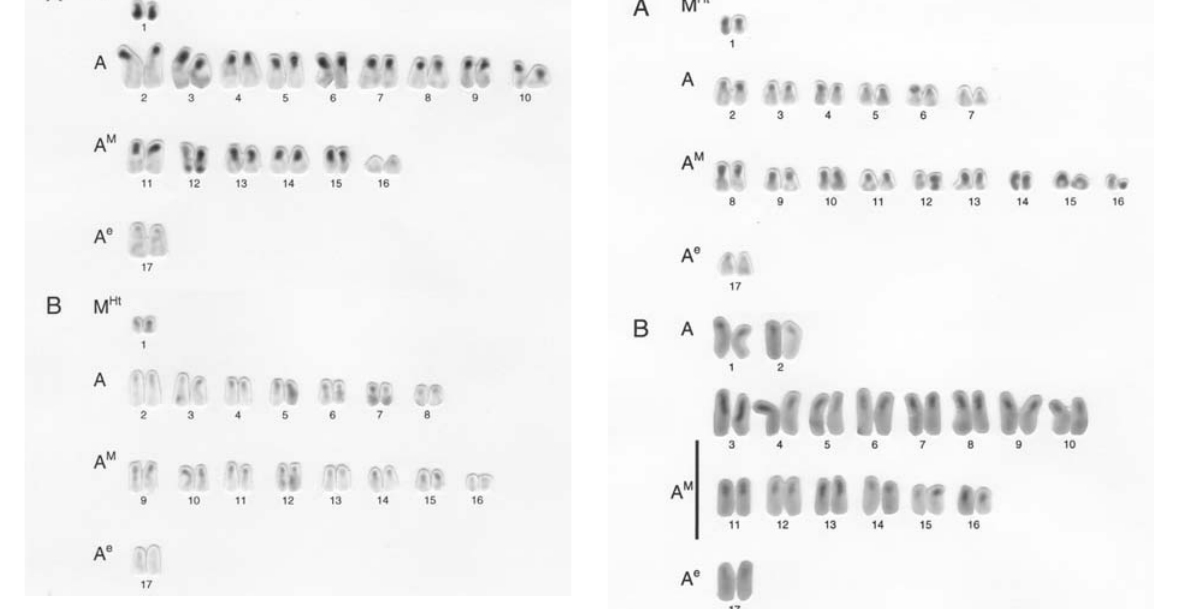
Figure 2 - Karyotypes assembled from metaphases of female Trigona recursa (A) and Trigona hyalinata (B) following C-banding.